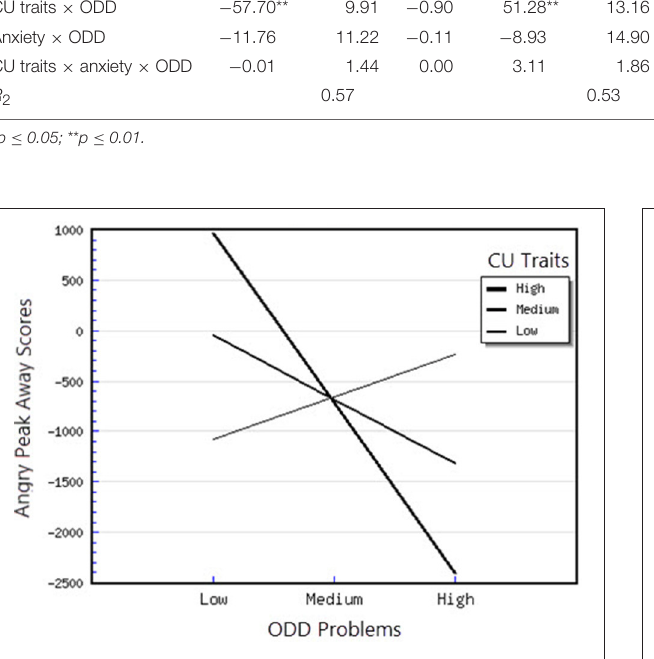
other for the teacher rate of ODD-related problems. For both regressions, there was no evidence of significant interactions between negative affectivity and effortful control ( B = 0.73, p = 0.73 for the parent rate; B = − 0.95, p = 11, for teacher rate) in predicting ODD-related problems.